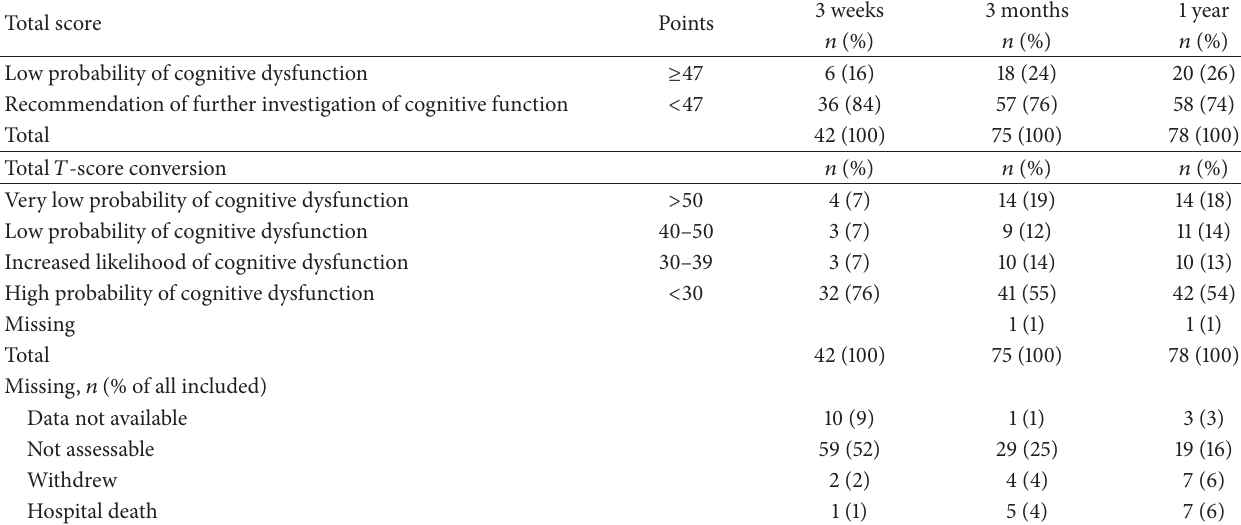
Table 5: BNIS total score and 𝑇 -score conversion, cut-off level of cognitive function ( 𝑛 = 114 ). Total